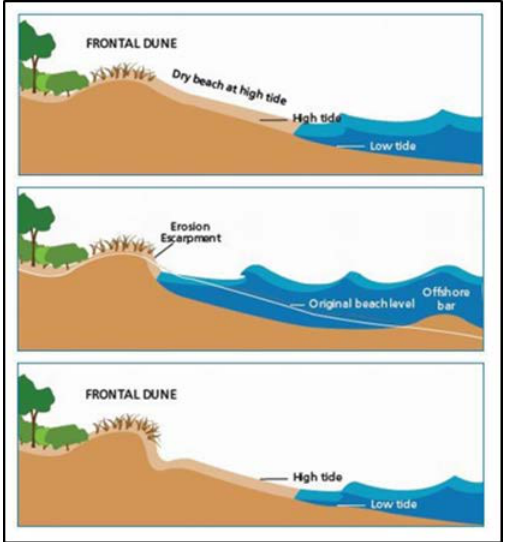
Figure 2. Coastal Erosion Process (Source: NRC, n.d.) The phenomena of sea level rise, affects the change of coastline through the process of accretion and erosion (Mohamad et al., 2014). Union of Concerned Scientists (UCS) saying that, global warming is the primary cause of current sea level rise (UCS, 2013). The figure of sea level rise is affecting the coastline changes represented as Figure 3 below where it show storm surge and high tides magnify the risks of local sea level rise.